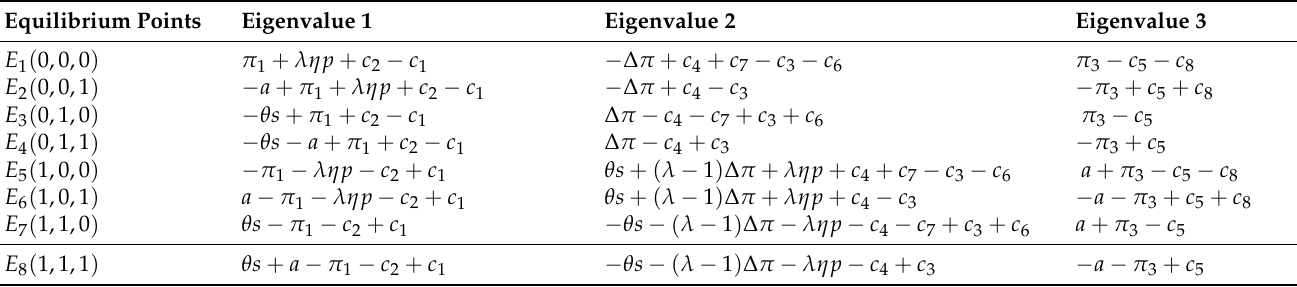
Table 3. The eigenvalues of Jacobian matrix